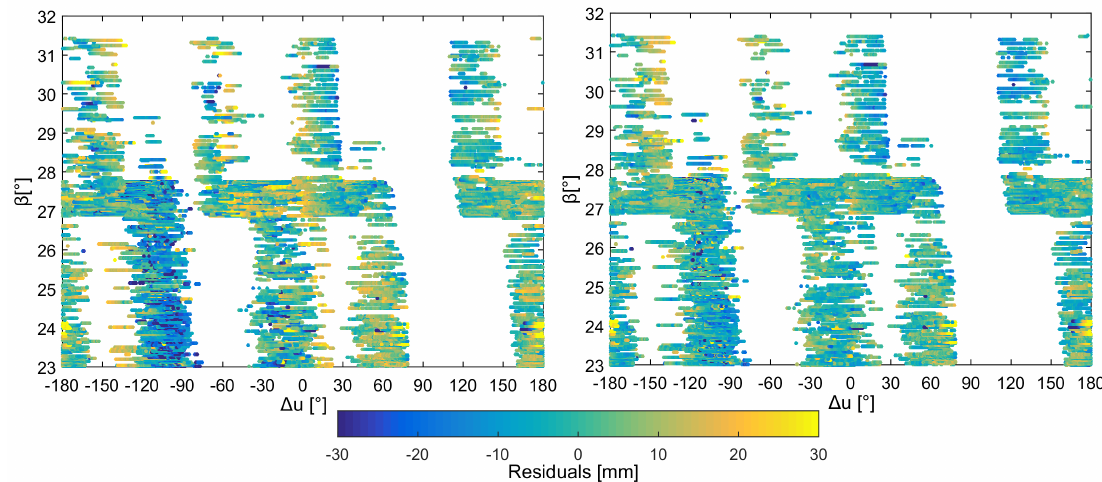
Figure 3. Dependency of residuals on S3A as a function of β and ∆ u angles for solutions with uncorrected ( left ) and corrected ( right ) range